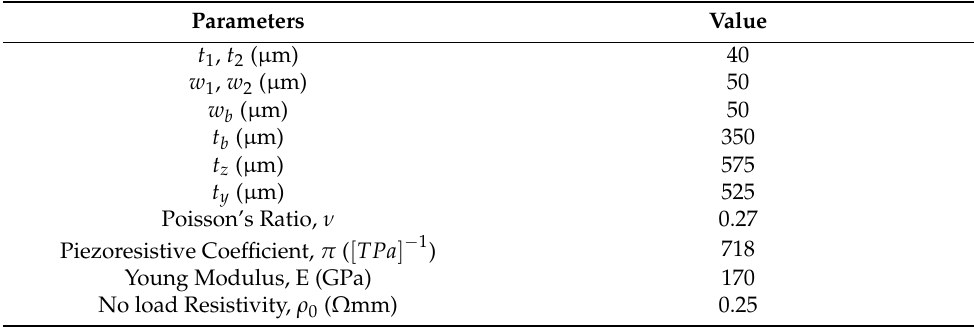
Table 2. Geometrical and mechanical parameters used in the COMSOL